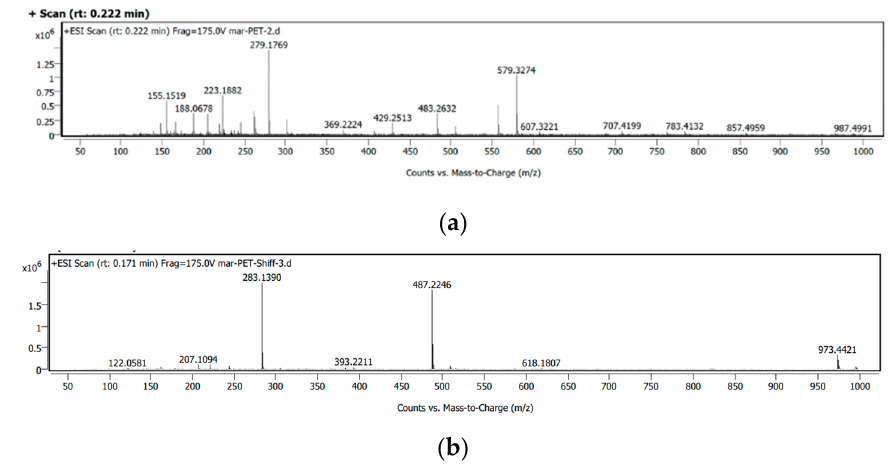
Figure 7. ESI-HRMS of aminolysed product obtained by method C (a) and the Schiff base (b). Table 2. Molecular formula and mass of the aminolysed products.